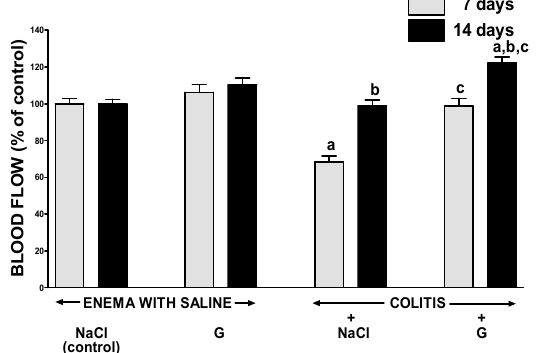
Figure 4. Effect of intraperitoneal administration of saline (NaCl) or ghrelin (G) on blood flow in colonic mucosa after seveb or 14 days from enema with saline or colitis induction. Mean value ± SEM. n = 10 animals in each group. a p < 0.05 compared to control at the same time of observation; b p < 0.05 compared to a value observed at the same group after seven days from colitis induction; c p < 0.05 compared to rats with colitis treated with NaCl at the same time of observation.